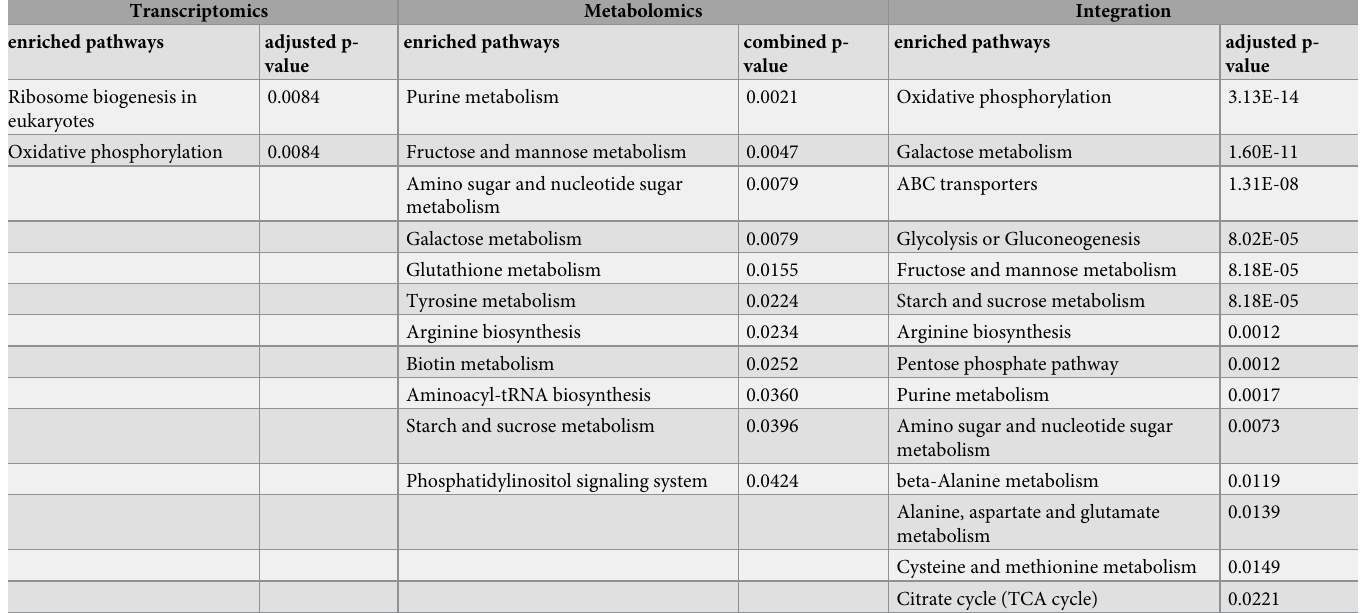
Table 2. Single- and multi-omics integration results for gpa2 by concentration analysis. First block shows GSEA for transcriptomics with adjusted p-value < 0.05, arranged in ascending order; second block shows MetaboAnalystR pathway enrichment analysis for metabolomics with combined p-value < 0.05, arranged in ascending order; third block shows MetaboAnalystR joint pathway analysis with adjusted p-value < 0.05, arranged in ascending order, as detailed in Methods.